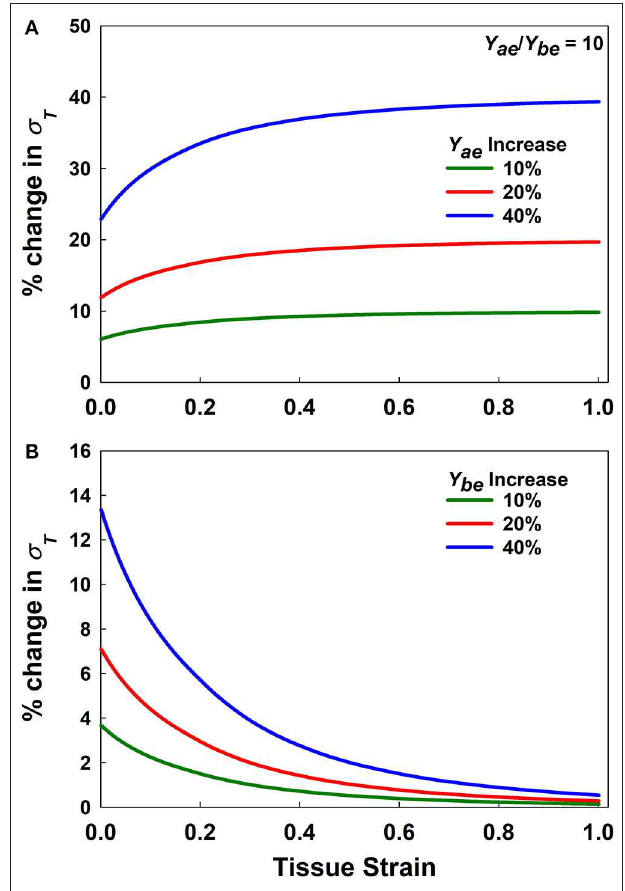
FIGURE 3 | Sensitivity analysis. (A,B) % change in stress for increasing Y ae and Y be , respectively by 10, 20, and 40% for Y ae / Y be = 10.